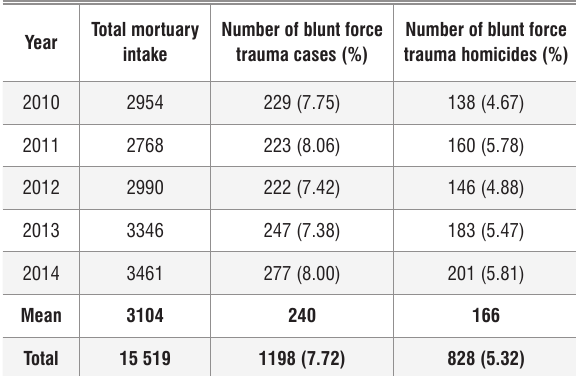
The prevalence of total blunt force trauma cases and blunt force trauma homicide cases at Salt River Mortuary from 2010